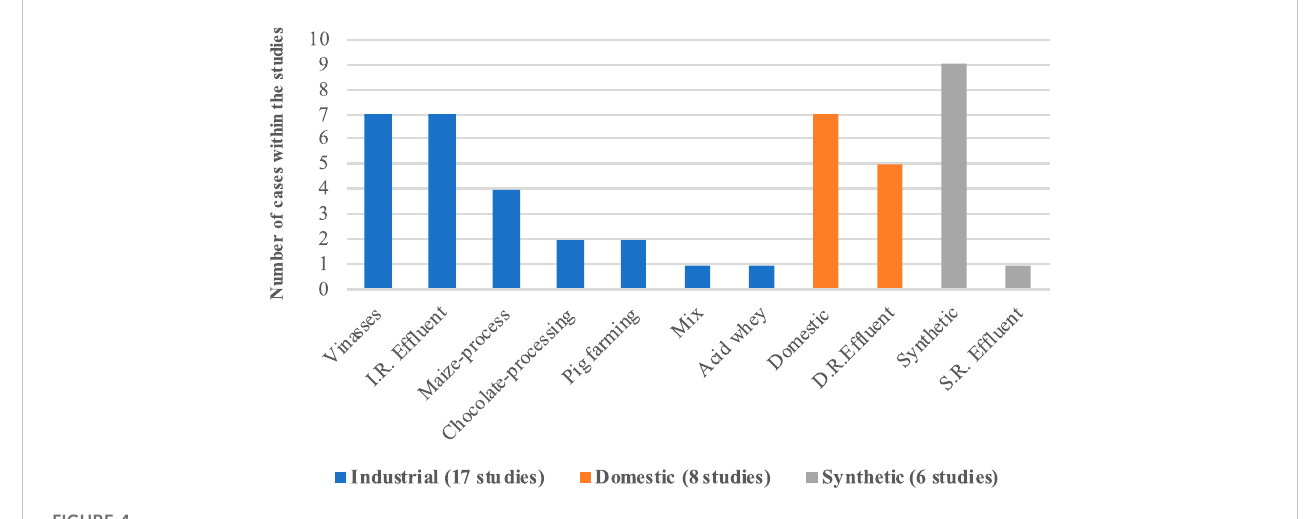
FIGURE 4 Type of wastewater treated to recover energy and number of cases in the selected